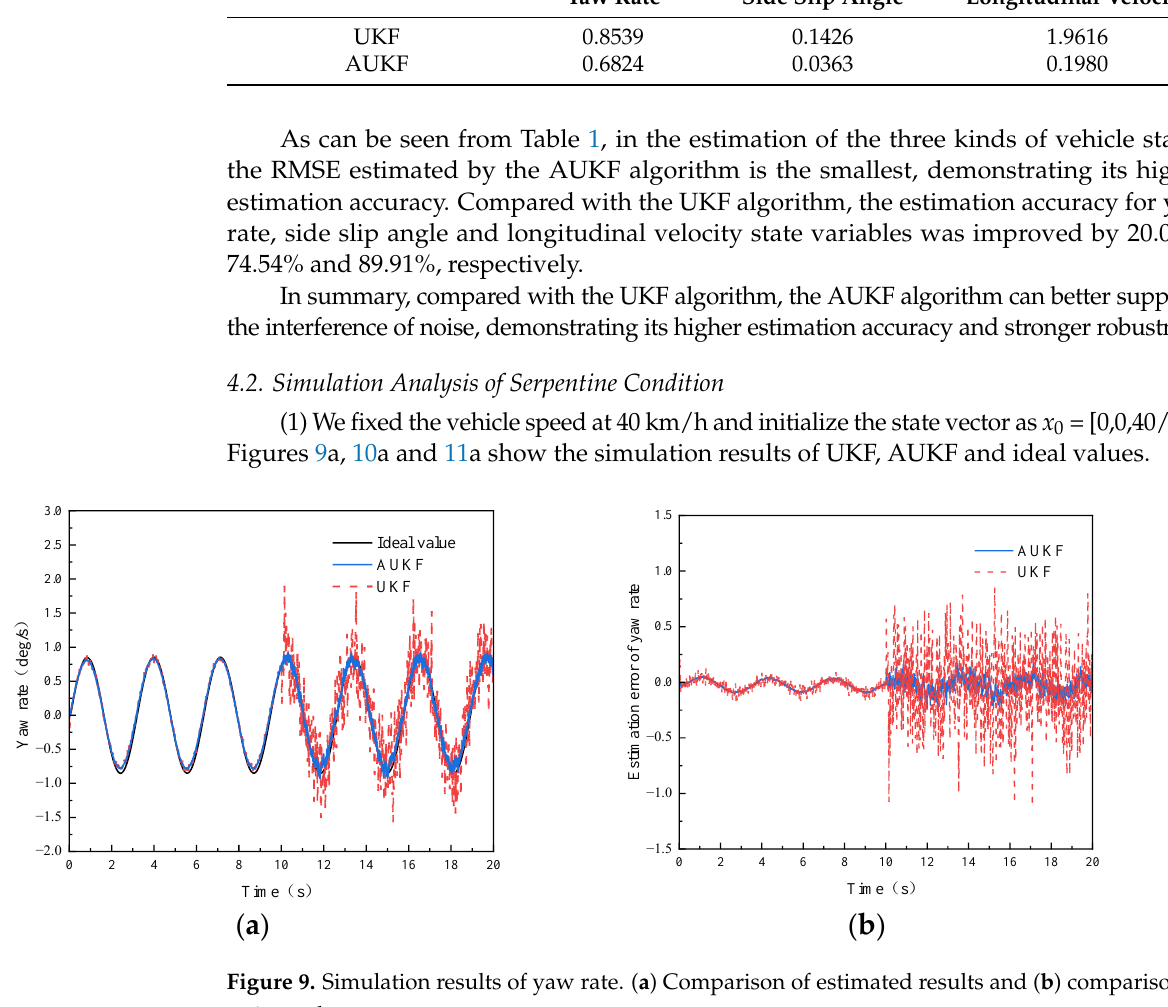
Table 2. RMSE of the two algorithms during the entire duration of the process. Estimation Algorithm RMSE of State VARIABLE Estimation